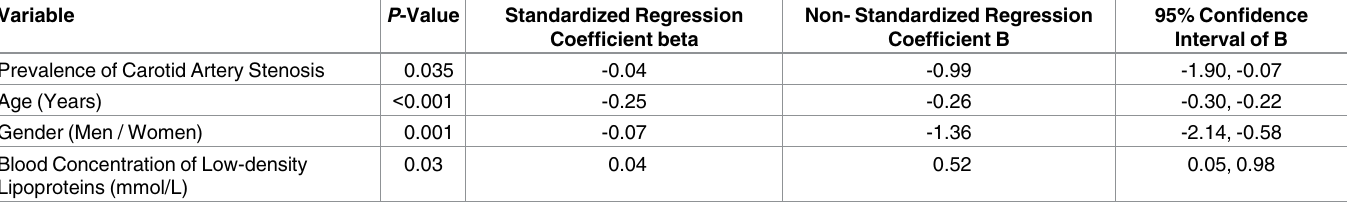
Table 2. Associations between retinal nerve fiber layer thickness ( μ m) (Linear multivariate regression analysis) and other variables in the asymp- tomatic polyvascular abnormalities in community study.